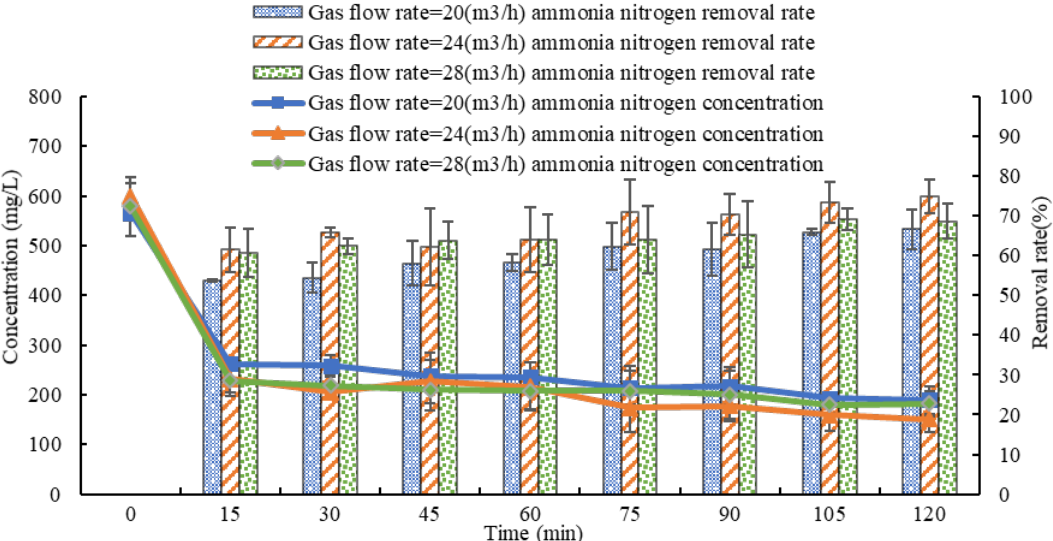
Figure 4. Variations in the concentration and removal rate of ammonia nitrogen with time in biogas slurry with different gas flow rates.